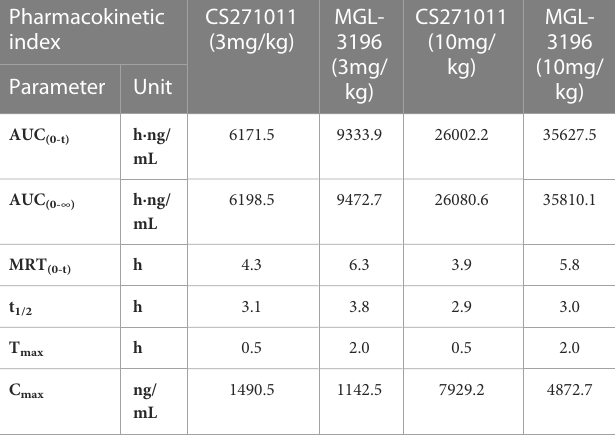
TABLE 2 Pharmacokinetic study in normal C57BL/6J mice by orally once.